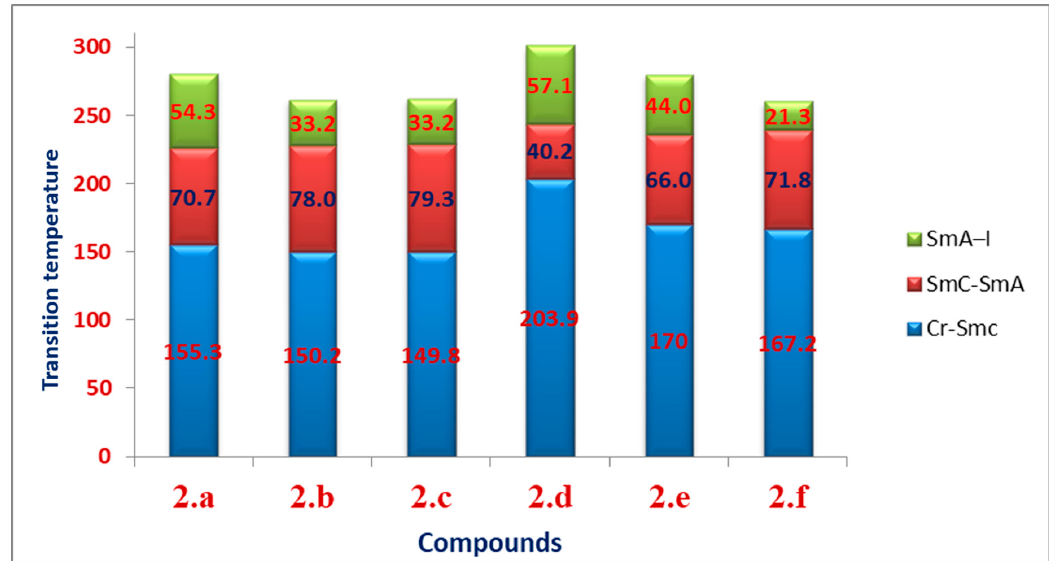
Figure 4. Graphical representation of dependence of mesomorphic phase ranges on the terminal chain length of the new compounds.